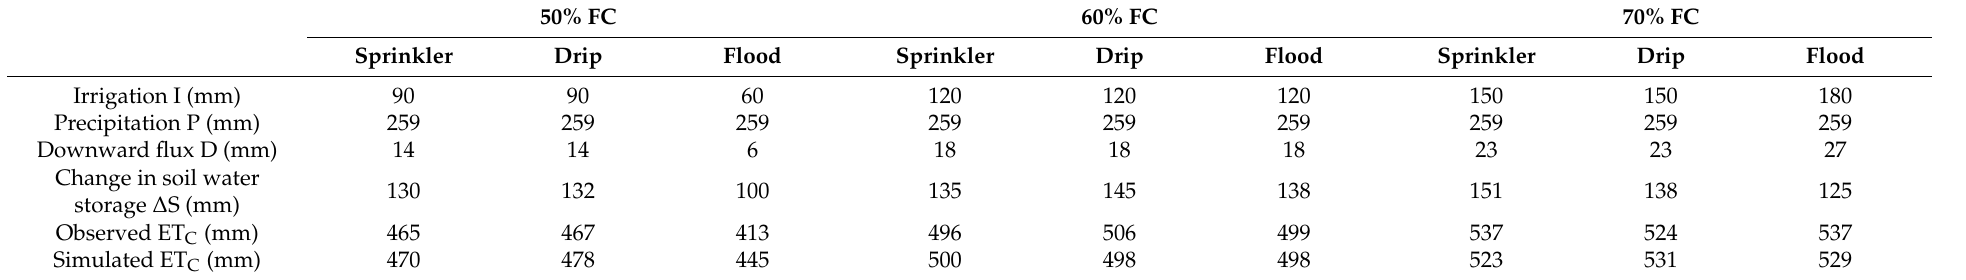
Table 11. Soil water balance in the top one-meter soil profile during 2017–2018 growing season.